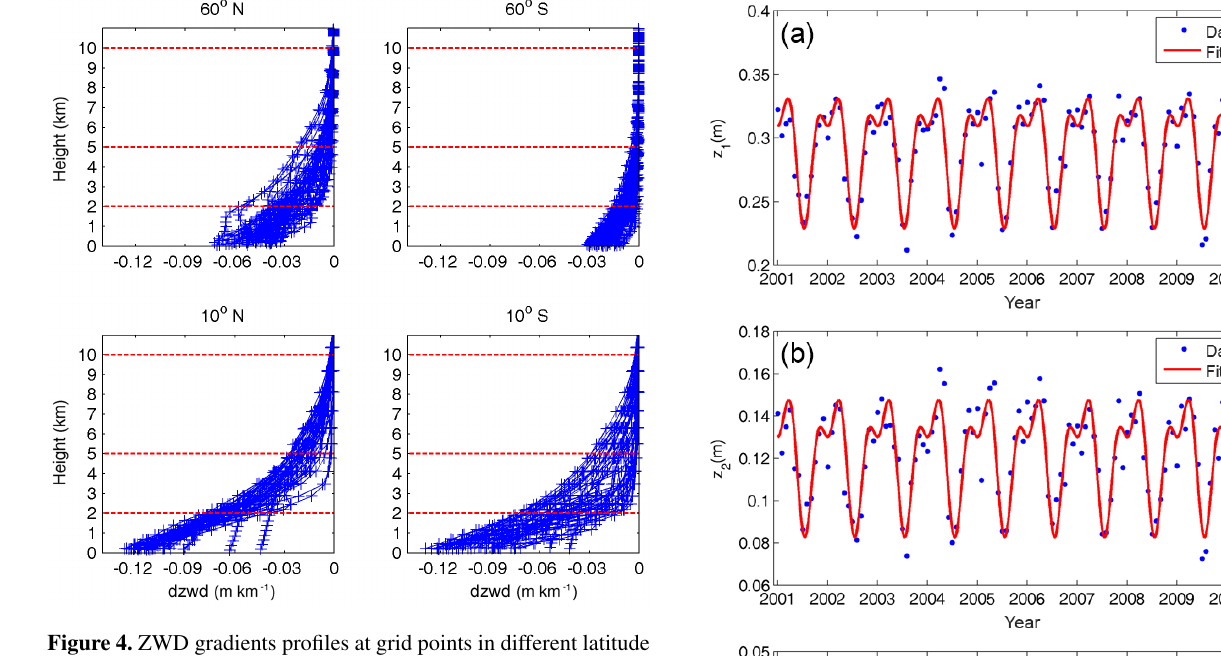
Figure 4. ZWD gradients profiles at grid points in different latitude bands (12:00UTC, 1 July 2010).